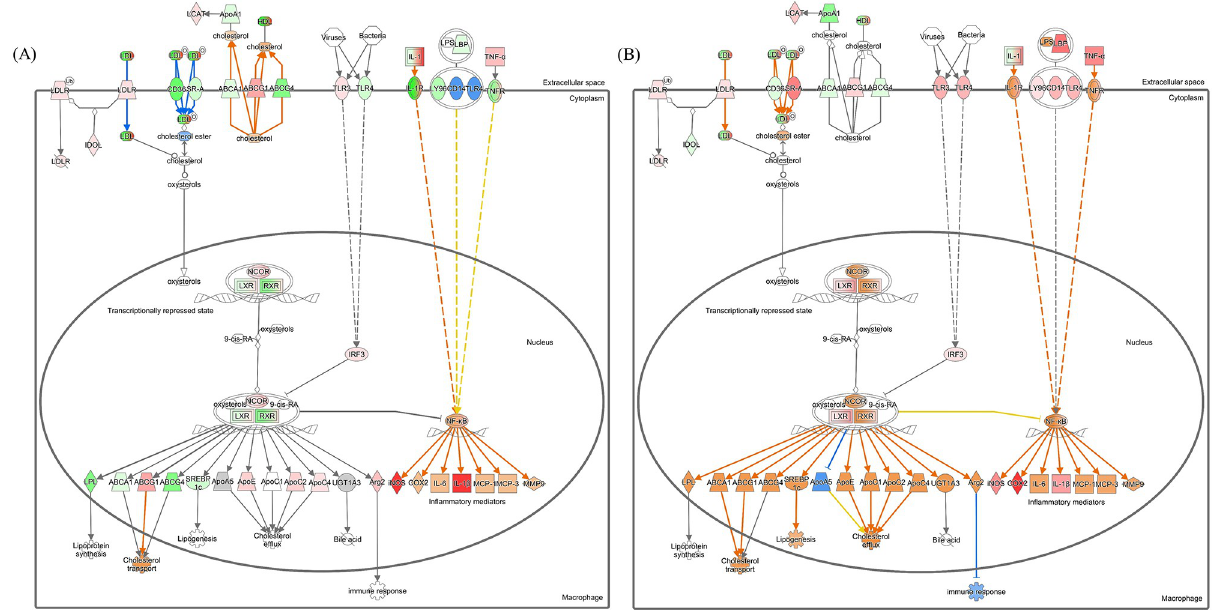
Fig 7. LXR/RXR activation pathways in the (A) MLN and (B) spleen of the IP group at 6 weeks PI. Nodes are colored based on gene expression along with predictions of upstream and downstream molecules. A gene in red indicates upregulation, a gene in green indicates downregulation, a gene in orange indicates predicted activation, and a gene in blue indicates predicted inhibition. Uncolored nodes indicate that genes were not differentially expressed in the pathway shown.